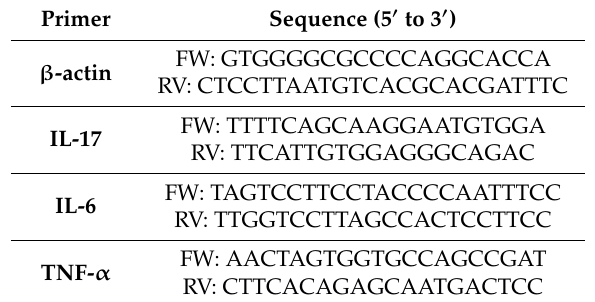
Table 1. Primer sequences used for real time polymerase chain reaction (PCR) in mouse. Primer Sequence (5 (cid:48) to 3 (cid:48) ) β